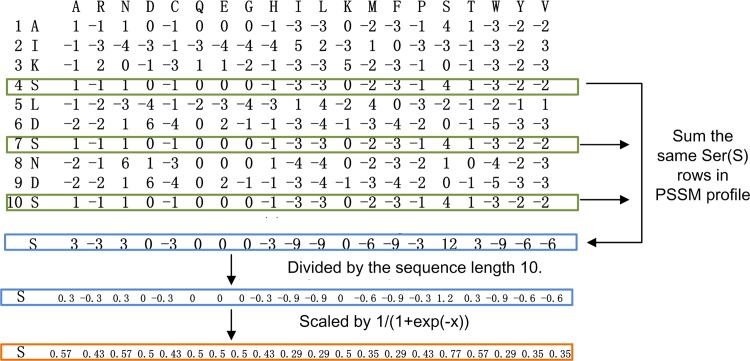
Example computation of scores from the PSSM profile.